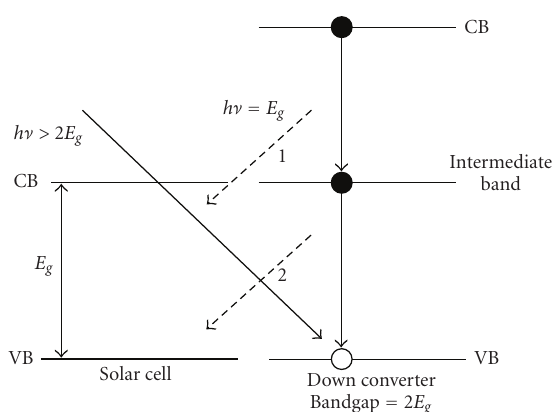
Figure 8: A photon with energy more than 2 E g strikes on down converter and produces two photons with energy E g